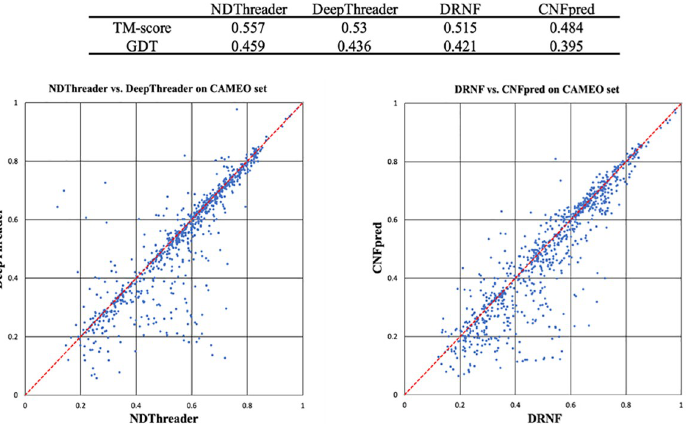
Fig 3. Alignment quality (TM-score and GDT) comparison between DRNF, CNFpred, NDThreader and DeepThreader on the CASP13 alignment test set. Top: average alignment quality (TM-score and GDT) on the CASP13 alignment test set. GDT is scaled to [0, 1]. Bottom left: NDThreader vs. DeepThreader. Bottom right: DRNF vs. CNFpred. Each point represents the quality of two alignments generated by two competing methods for the same protein pair.